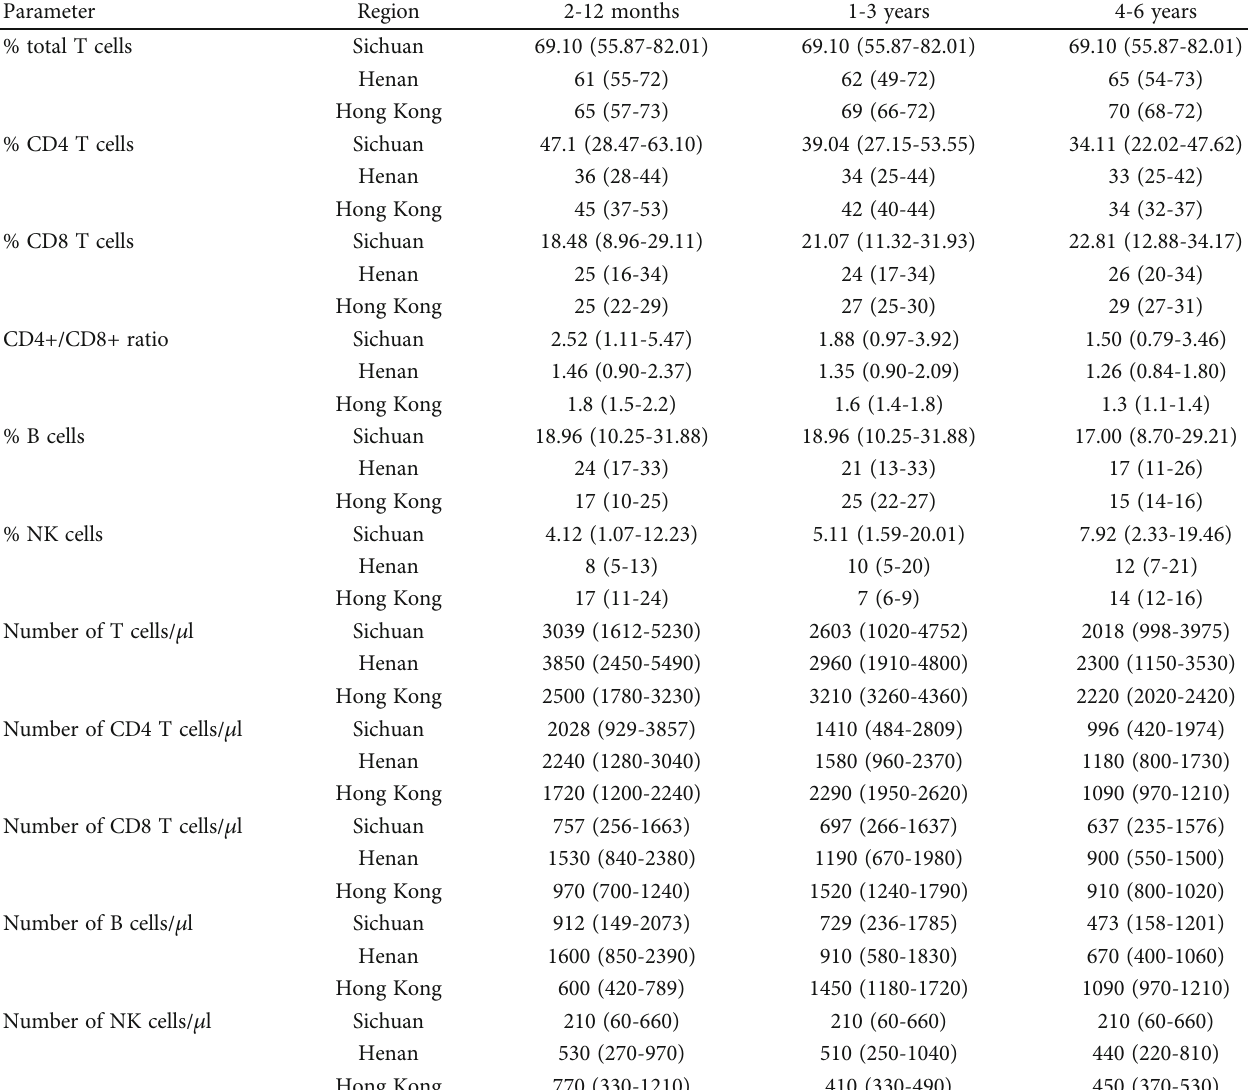
Table 3: Reference intervals of lymphocyte subsets in children: comparison among di ff erent regions in China.